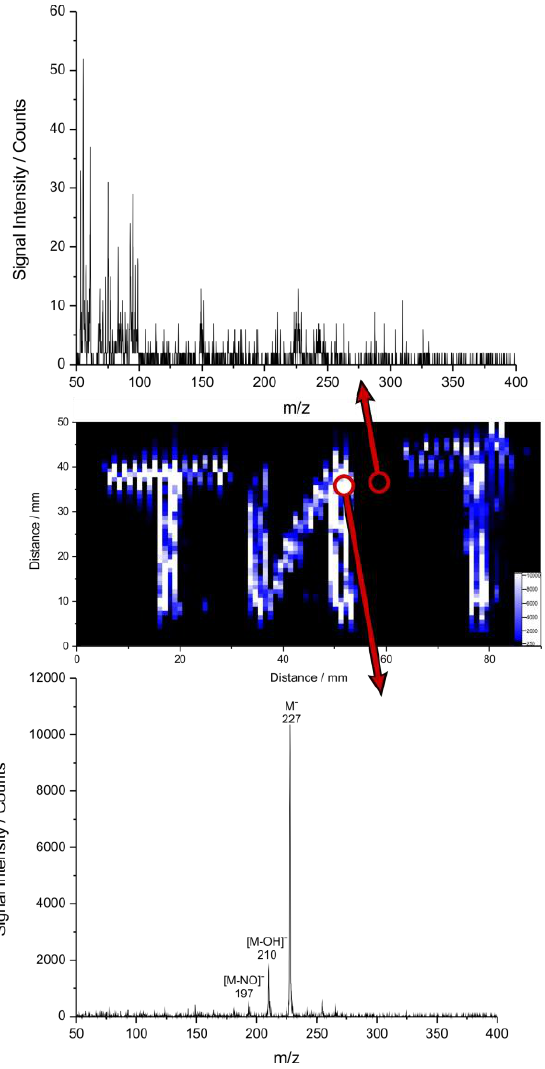
Figure 5. APLD mapping capabilities shown at a TNT example generated with CI negative detection mode. Two typical mass spectra can be seen above. If the position of the X-Y table and the signal intensity is combined at any point of the surface the image on the top right can be achieved. This image shows a prepared stainless steel surface that was labeled with the word TNT. This label was produced with 1 mg/L TNT solution and a µL syringe. The total amount of substance applied for this image was about 20 µg. The color changes from black (no TNT detected) to white (high amounts of TNT detected). Therefore, the upper spectrum indicates a “black” area and the lower spectrum reveals the basis for a “white area”. For mapping purposes a LabVIEW TM script was created, which can be found in the Supplementary